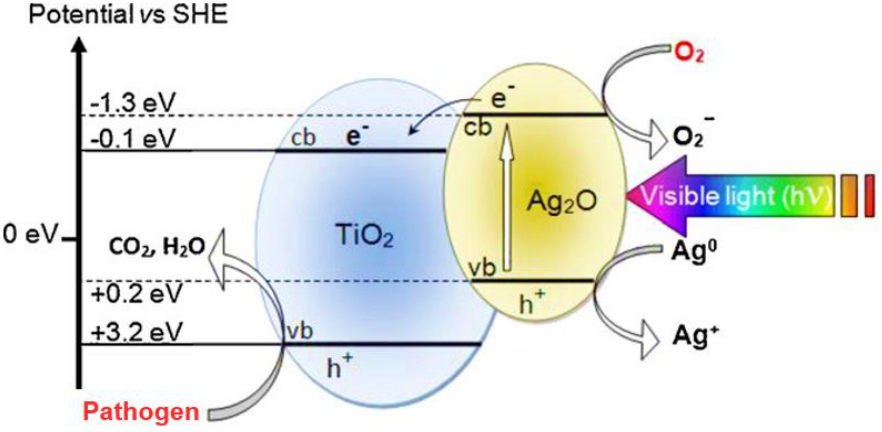
Figure 3. Interfacial charge transfer (IFCT) in TiO 2 /Ag NPS in solution under visible light. Ag surface plasmon resonance (SPR) sites build up in Ag clusters of TiO 2 /Ag surfaces and this favors light absorption. TiO 2 /Ag increases the generation of ROS radicals such as